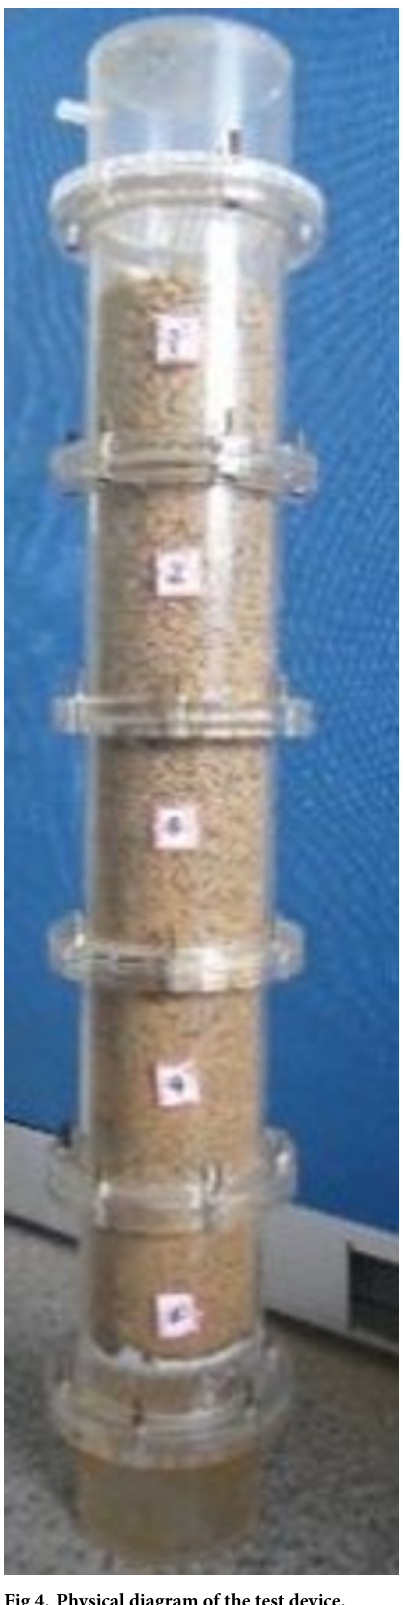
Fig 4. Physical diagram of the test